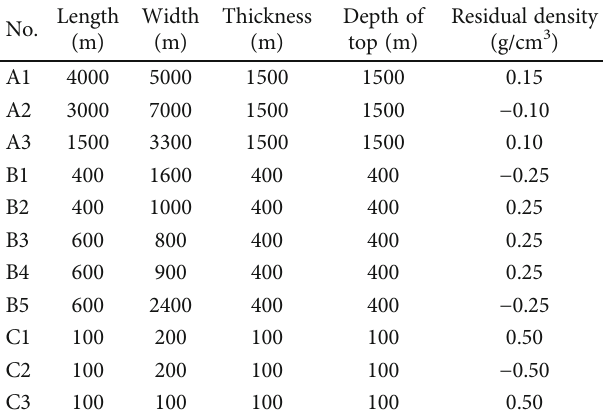
Table 1: Forward-modeling